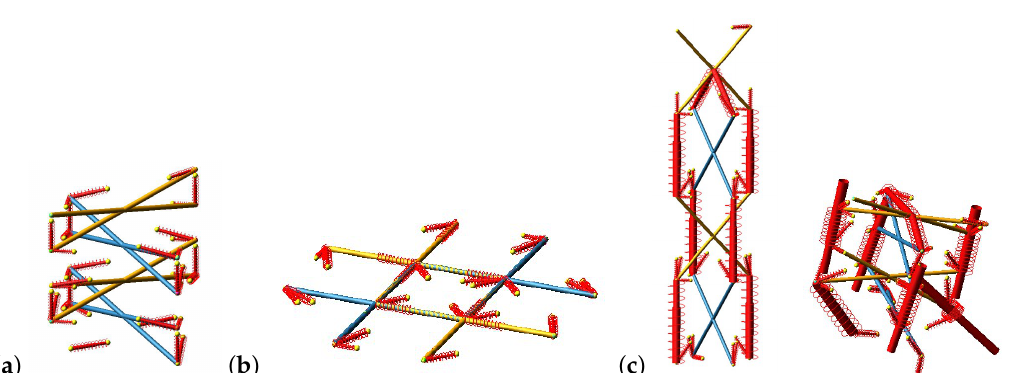
Figure 11. The X column deployment: ( a ) The first deployment scheme. ( b ) The second deployment scheme. ( c ) The third deployment scheme.